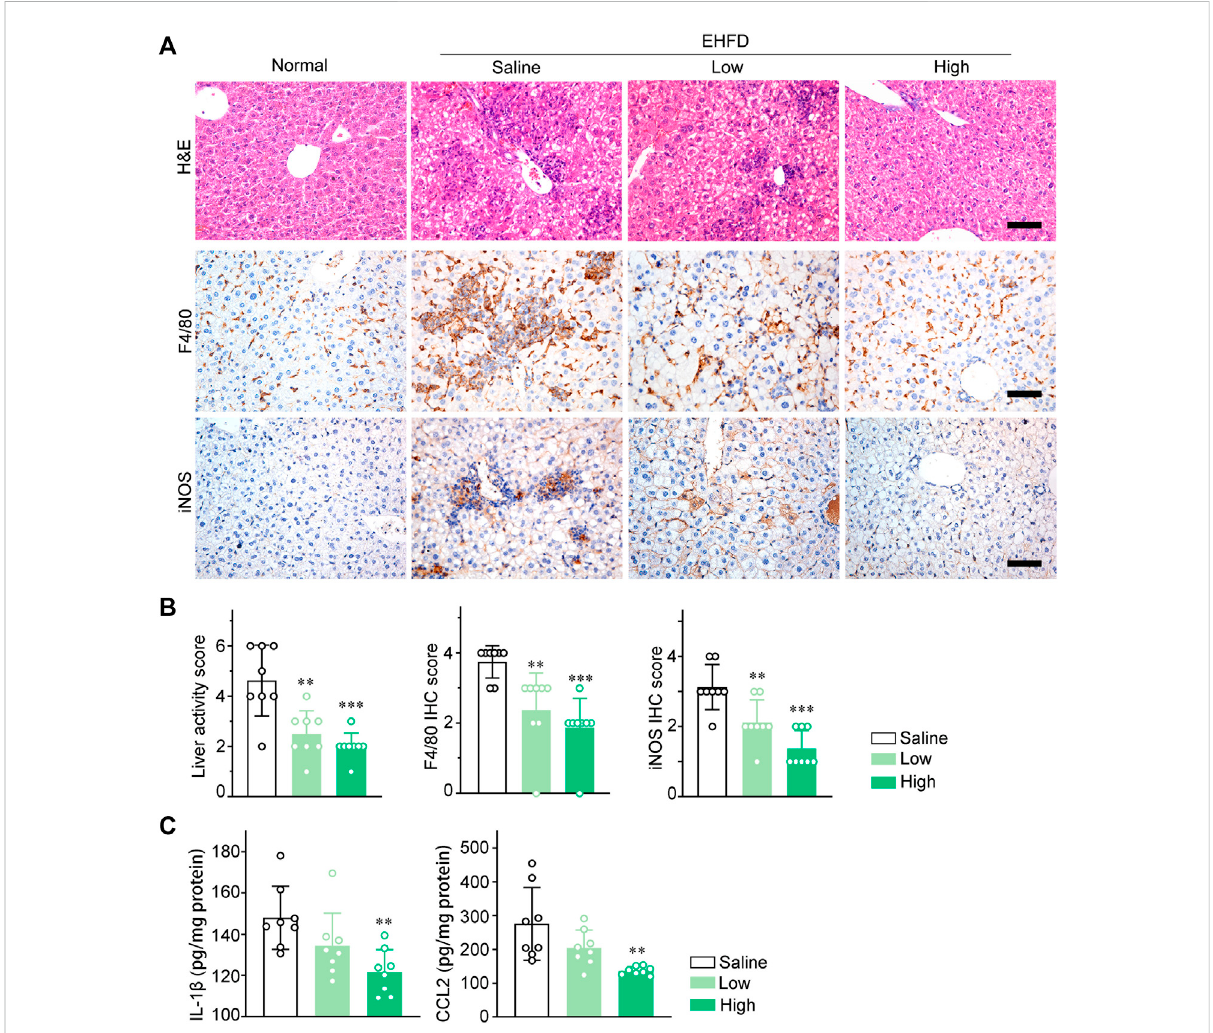
FIGURE 4 GLCsuppressesmacrophagein fi ltrationandpro-in fl ammatorycytokinesexpression invivo . (A)